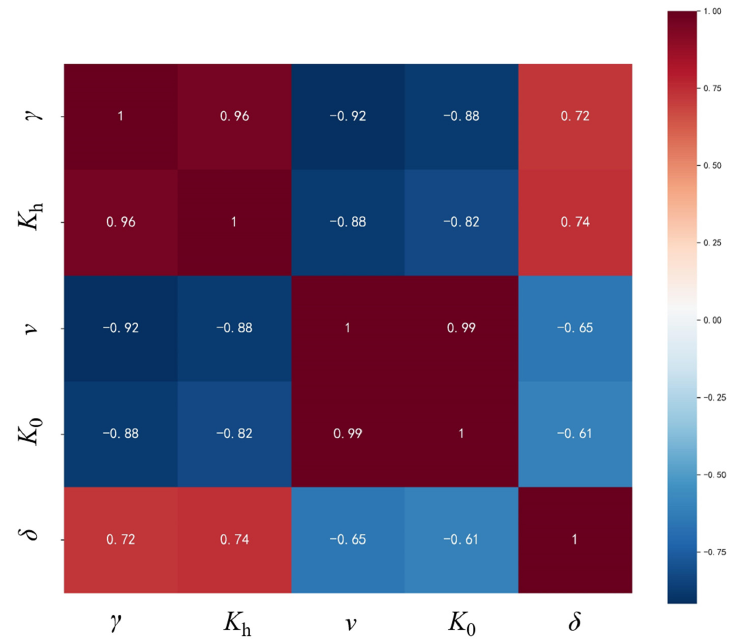
Figure 7. Correlation analysis of several geological parameters.